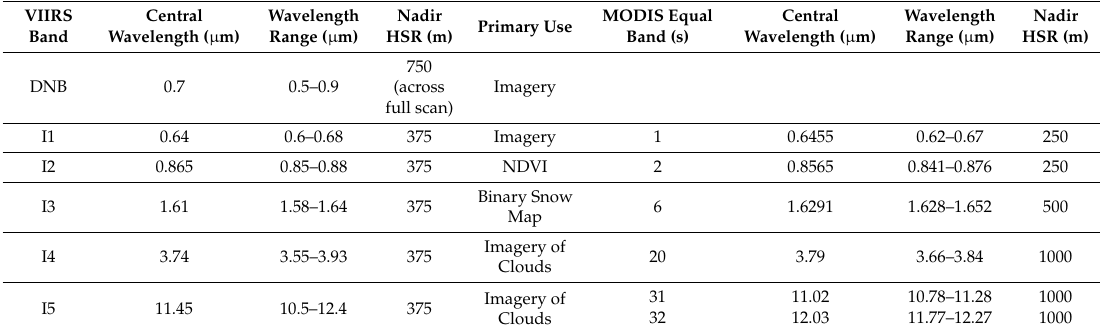
Table 2. VIIRS Spectral Bands (I) and MODIS Equivalent Bands (I for Imaging).